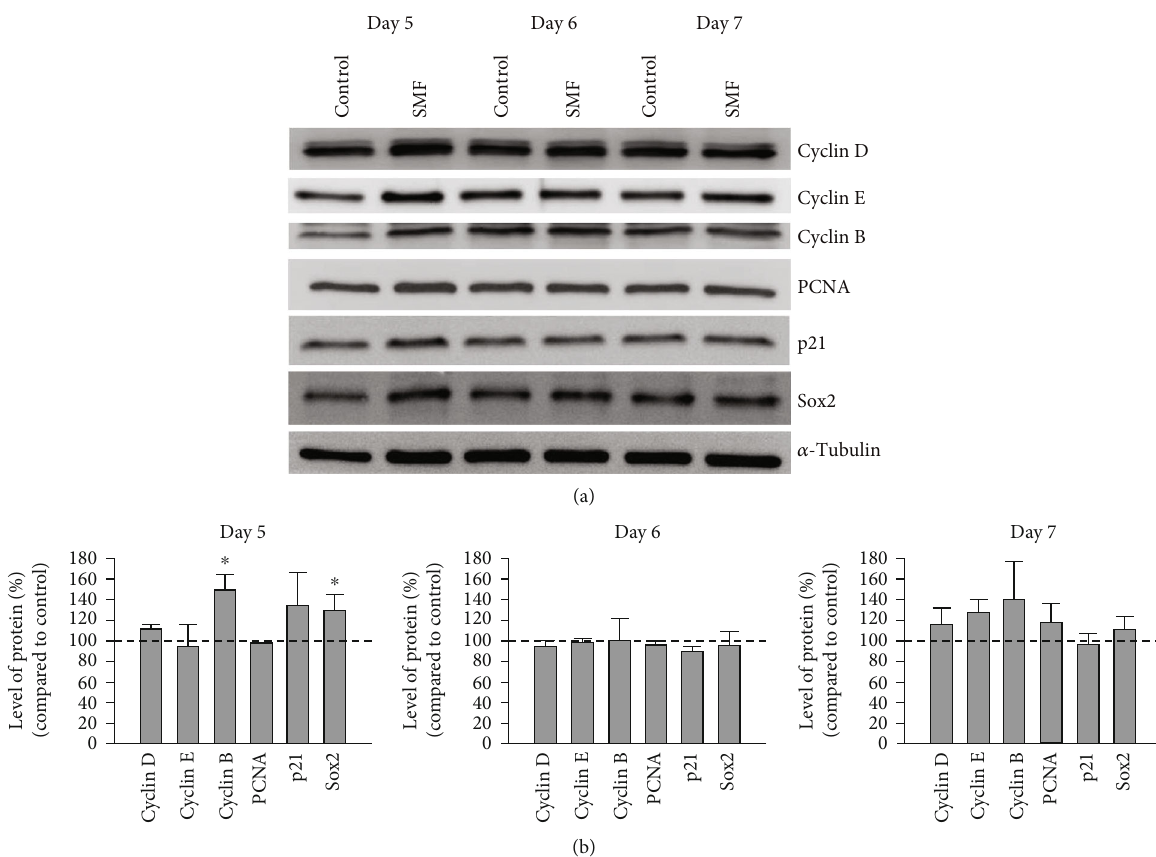
Figure 3: SMF mediated cell cycle progression of mNPCs. (a) Western blotting showing the level of cell cycle-related proteins expressed in mNPCs under SMF on days 5, 6, and 7. (b) Data in the graph represent fold changes, calculated relative to the values in the control groups, after 5, 6, and 7 days of SMF exposure. The levels of both cyclin B and Sox-2 in mNPCs were markedly increased after 5 day SMF. Blotting bands were analyzed using the ImageJ software for relative density and normalized to α -tubulin controls. Data represent the mean ± S : E : M : ; n = 2 ‐ 5 in each group; ∗ p < 0 : 05 ; Student ’ s t